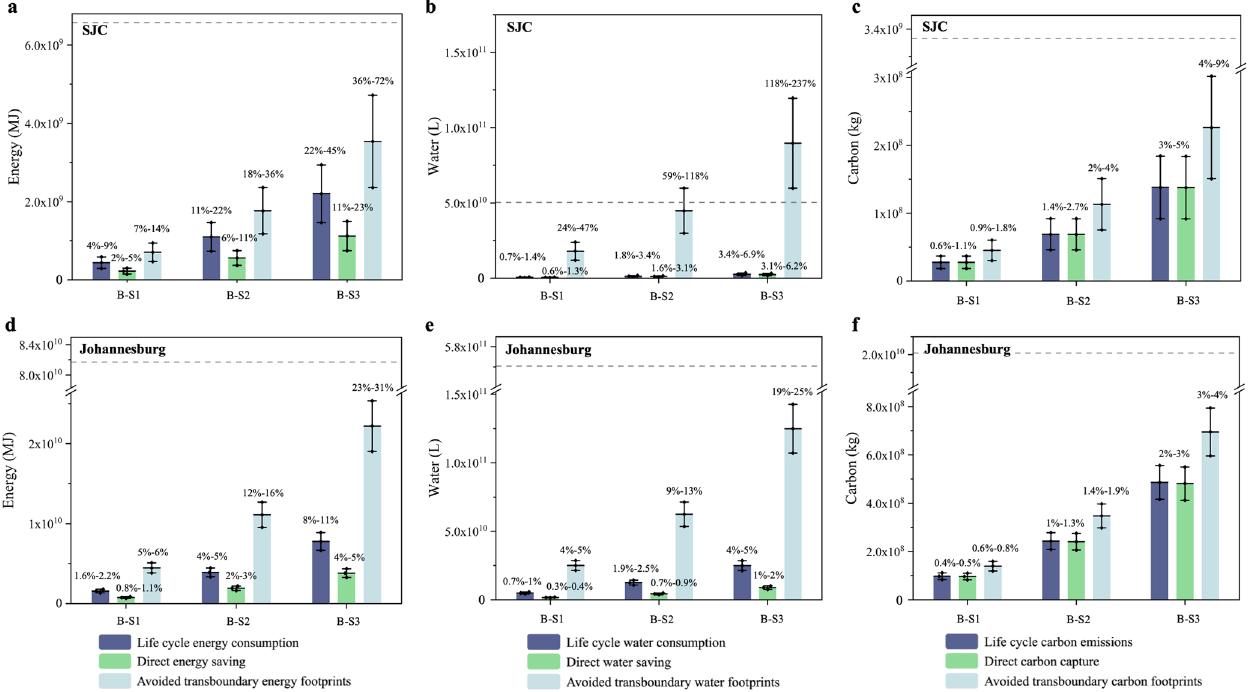
Fig. 6 Implications of city-wide green roofs in 30% of the available urban rooftop assumption. a – c The implications of green roof in SJC about energy, water, and carbon from left to right. d – f illustrate the implications of green roofs in Johannesburg about energy, water, and carbon from left to right. Taking panel ( a ) as an example, the three columns in different colors refer to the energy implications (i.e., life cycle energy consumption, direct energy saving, and avoided transboundary energy footprints) respectively in scenarios B-S1, B-S2, and B-S3 in SJC. The dotted line at the top presents the city ’ s energy demand, which is used to compare with the life cycle energy consumption, direct energy saving, and avoided transboundary energy footprints of urban green roofs. The city-wide energy implications of green roofs vary because the urban roof area is a range. The percentages above the column that indicate the minimum and maximum values of the proportion of the energy implications to the urban energy demand, are accordingly in a range.